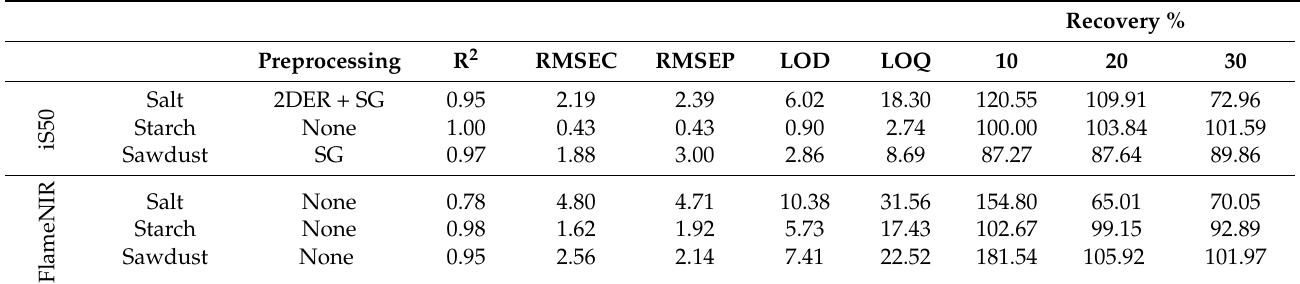
Table 5. PLS-R models developed using spectral data from the benchtop Thermo iS50 and portable Flame-NIR on TQ Analyst.